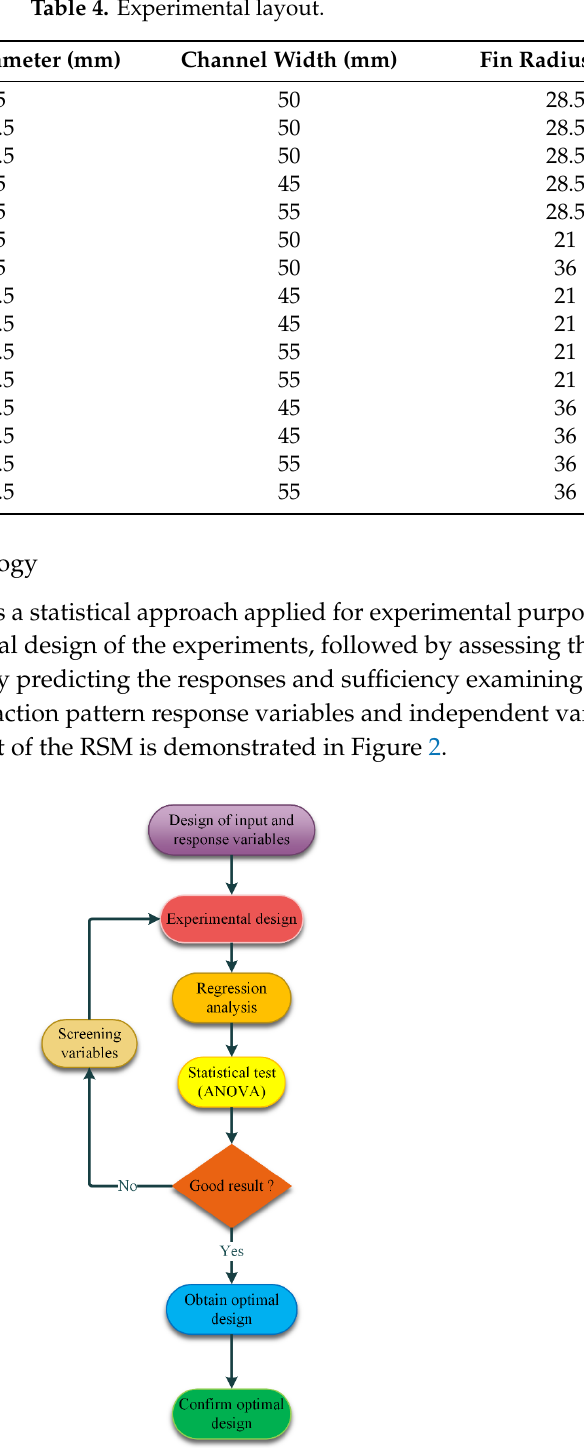
Figure 2. The response surface methodology (RSM) flowchart.